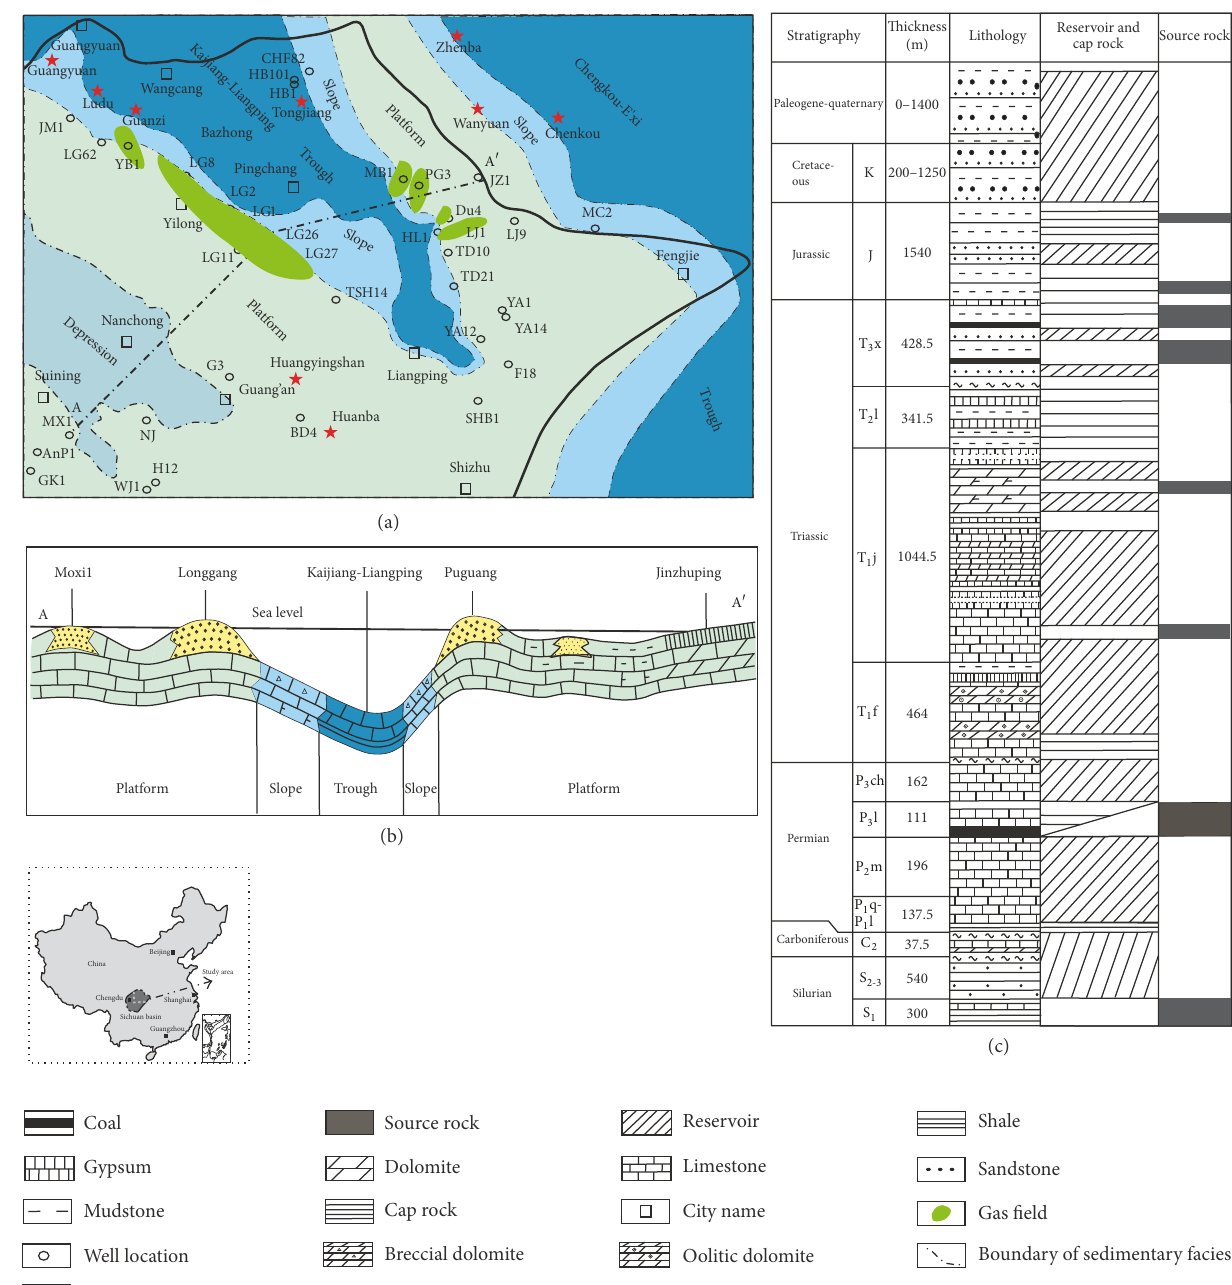
Figure 1: Diagrams showing (a) location of major gas fields, (b) distribution of sediment facies during the Changxing-Feixianguan deposition period, and (c) generalized stratigraphy. Possible source rock and reservoir intervals are marked. (Modified from Hu et al. (2014) [19].)